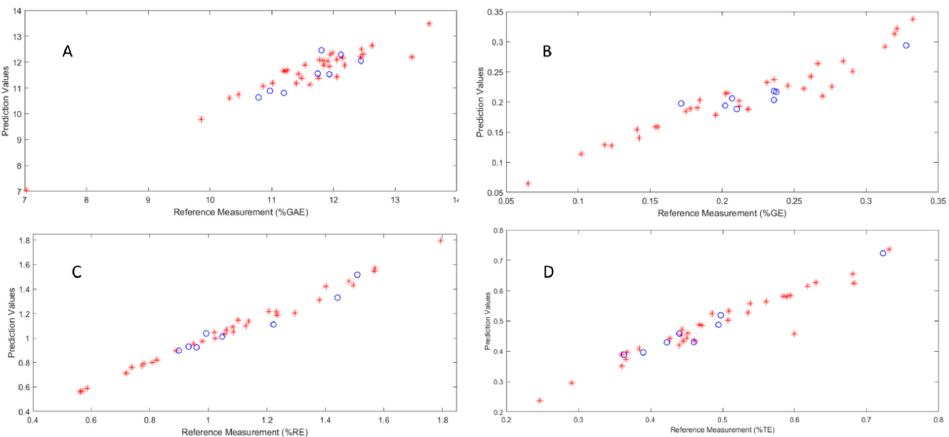
Figure 2. The calibration models for tea polyphenol ( A ), tea polysaccharide ( B ), total flavonoid ( C ) and antioxidant activities ( D ), respectively. Red circles and blue asterisks represent calibration and prediction test samples, respectively.